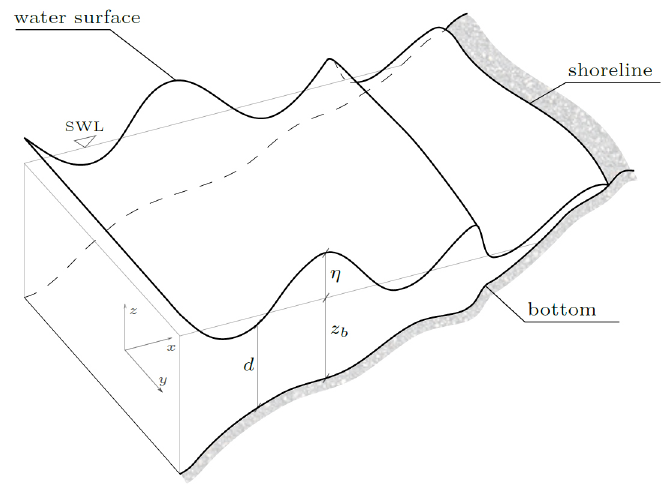
Figure 1. Schematics of the nearshore and representation of the involved